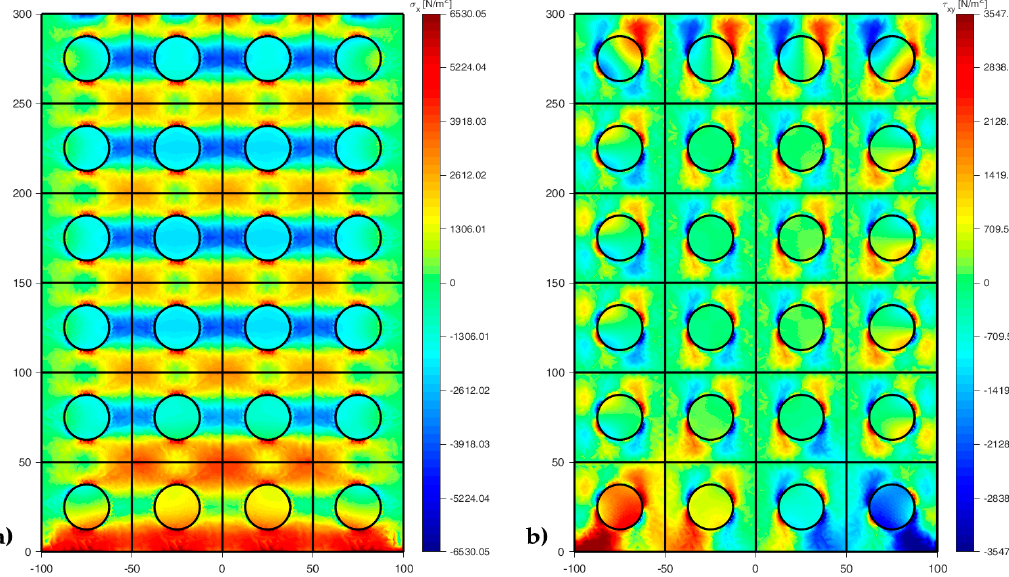
Figure 34. Stress fields in the 6 × 4 array subjected to uniaxial traction. ( a ) Normal stresses σ x and ( b ) shear stresses τ xy .